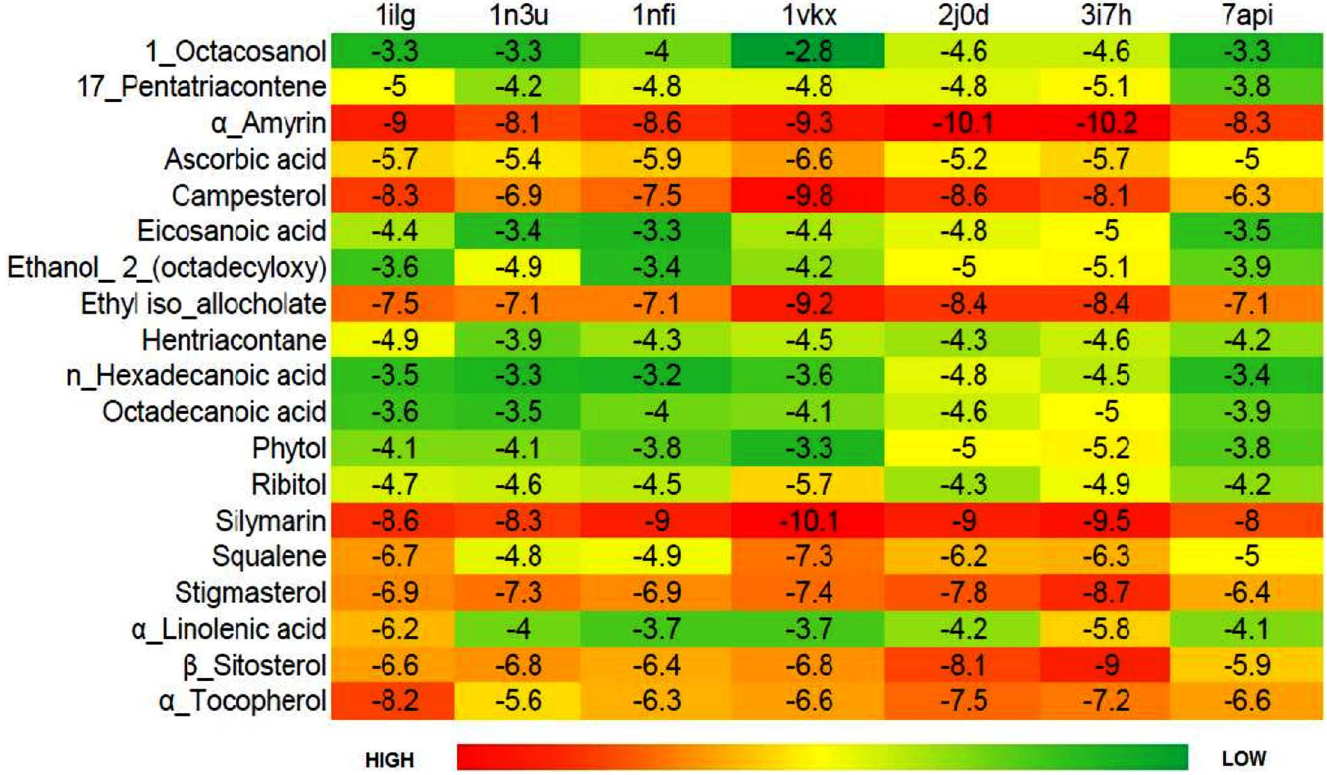
PLOS ONE | https://doi.org/10.1371/journal.pone.0196411 April 30,